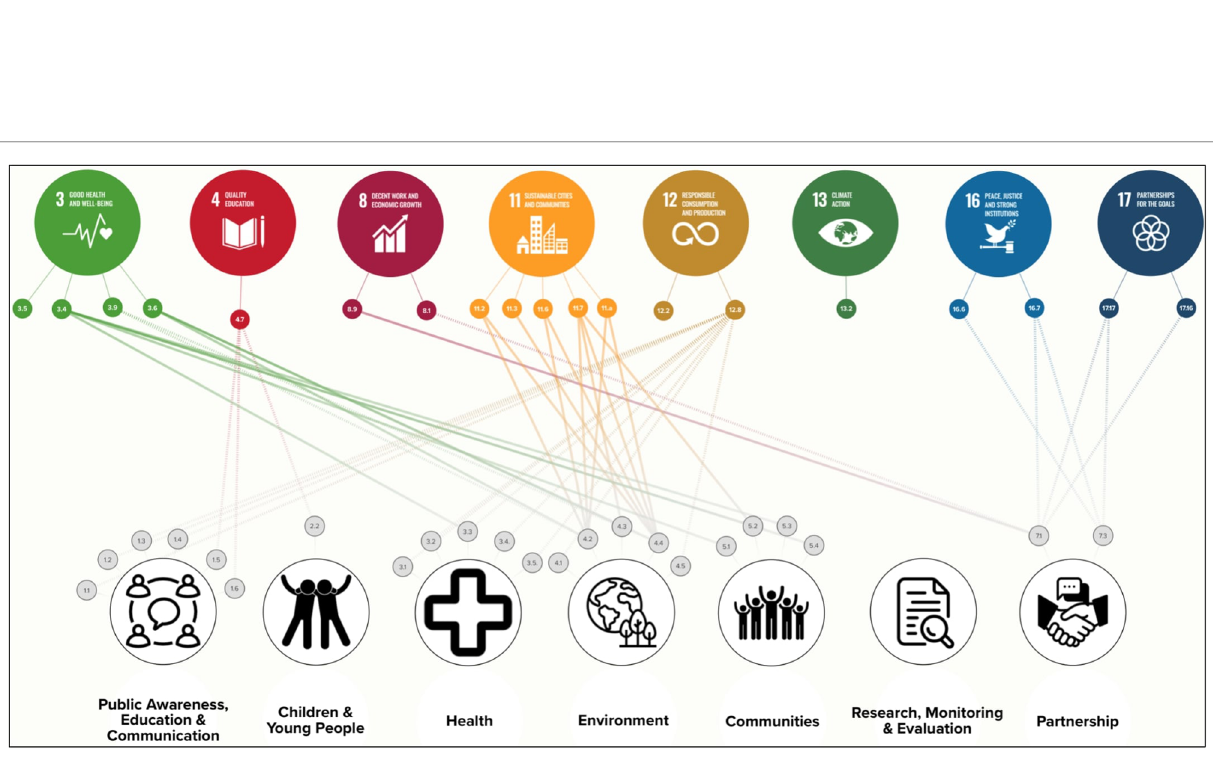
FIGURE 5 Walking related SDG ’ s and SDG targets (Top row) and their links to actions within the Get Ireland Walking Strategy and Action Plan 2017 – 2020 (bottom row) (solid line=SDG target identi fi ed as highly relevant to walking; dashed line=SDG target identi fi ed as partially relevant to